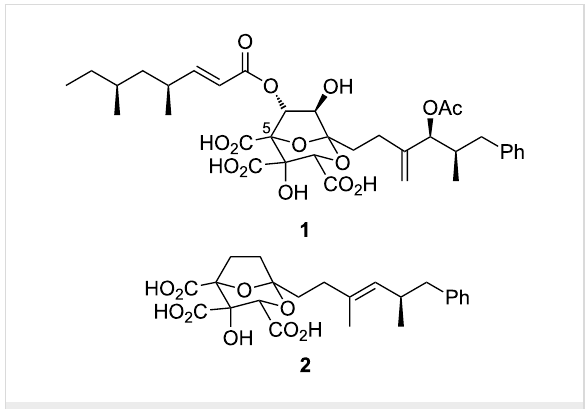
Figure 1: Squalestatin S1/zaragozic acid A ( 1 ) and DDSQ ( 2 ).